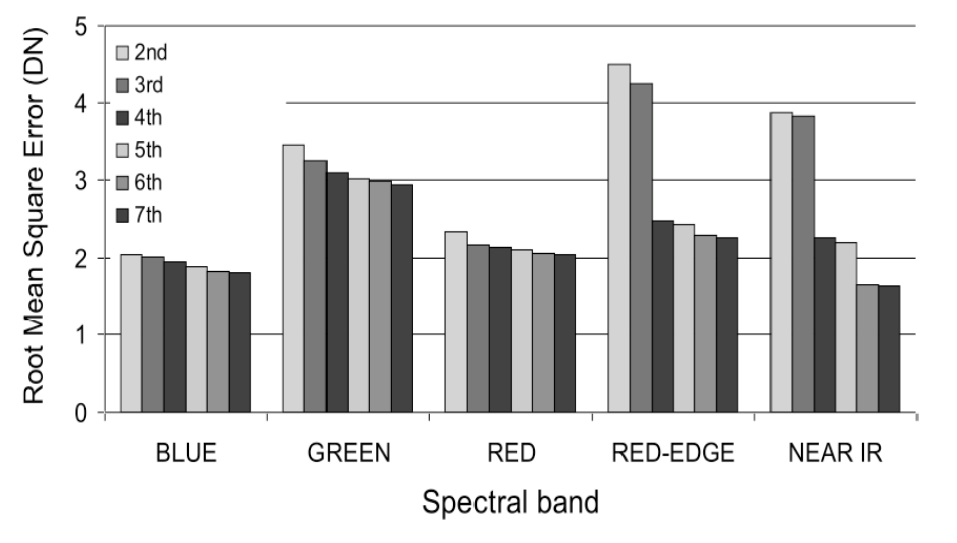
Figure 8. Effect of the polynomial degree of the vignetting function on the quality of the fitted model in each spectral